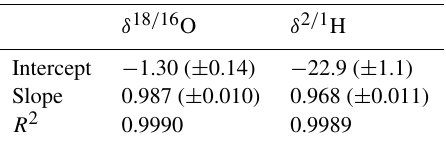
Figure 2. Relationship between volumetric solid:water ra- tio and apparent isotopic fractionation of (a) 18 / 16 O and (b) 2 / 1 H between unconfined water and total water adsorbed by different materials. Taken together, the regressions are y =− 0.906 x ( R 2 = 0.6789; N = 96) for the isotopic fractionation of 18 / 16 O and y =− 17.75 x ( R 2 = 0.8355) for the isotopic fraction- ation of 2 / 1 H. Table 1. Regressions between water adsorbed by silage ( δ T ) and unconfined water ( δ U ) for five types of water (very heavy, heavy, tap, light and very light water) based on equation δ T = slope × δ U + intercept; n = 40; values in parenthesis denote the 95% confidence